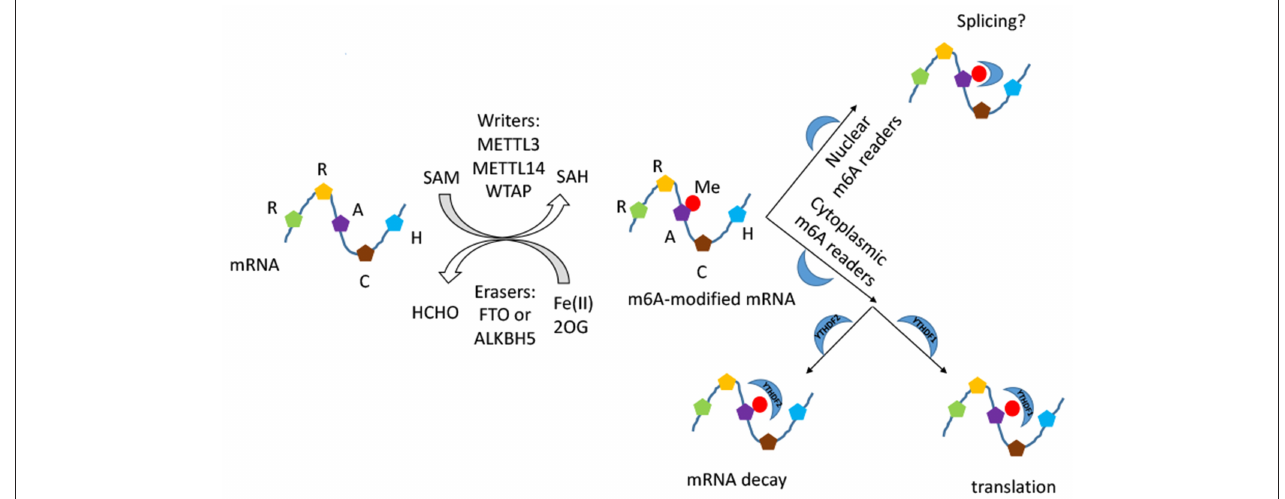
FIGURE 1 | The schematic diagram of m 6 A RNA modification. The process is composed of installation, removal, and identification performed by writers, erasers, and readers. The METTL3–METTL14–WTAP methyltransferase complex catalyses a methyl group transfered from SAM into the N6 position, and the demethylases FTO and ALKBH5 catalyse the oxidative demethylation from methylated adenosine. The methyl group introduced is marked in red. The readers of the YTH domain family are effectors that decode the m6A methylation code and transform it into a functional signal in nucleus and